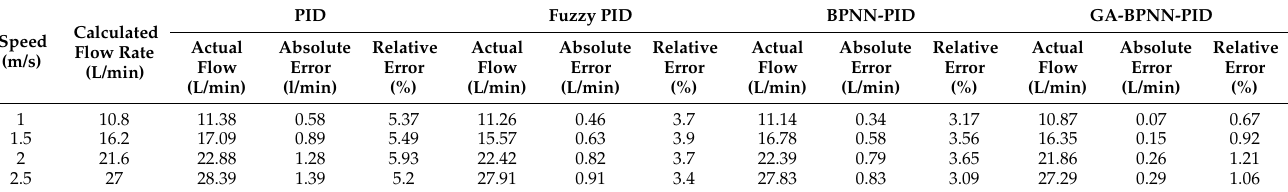
Table 2. Flow error of control